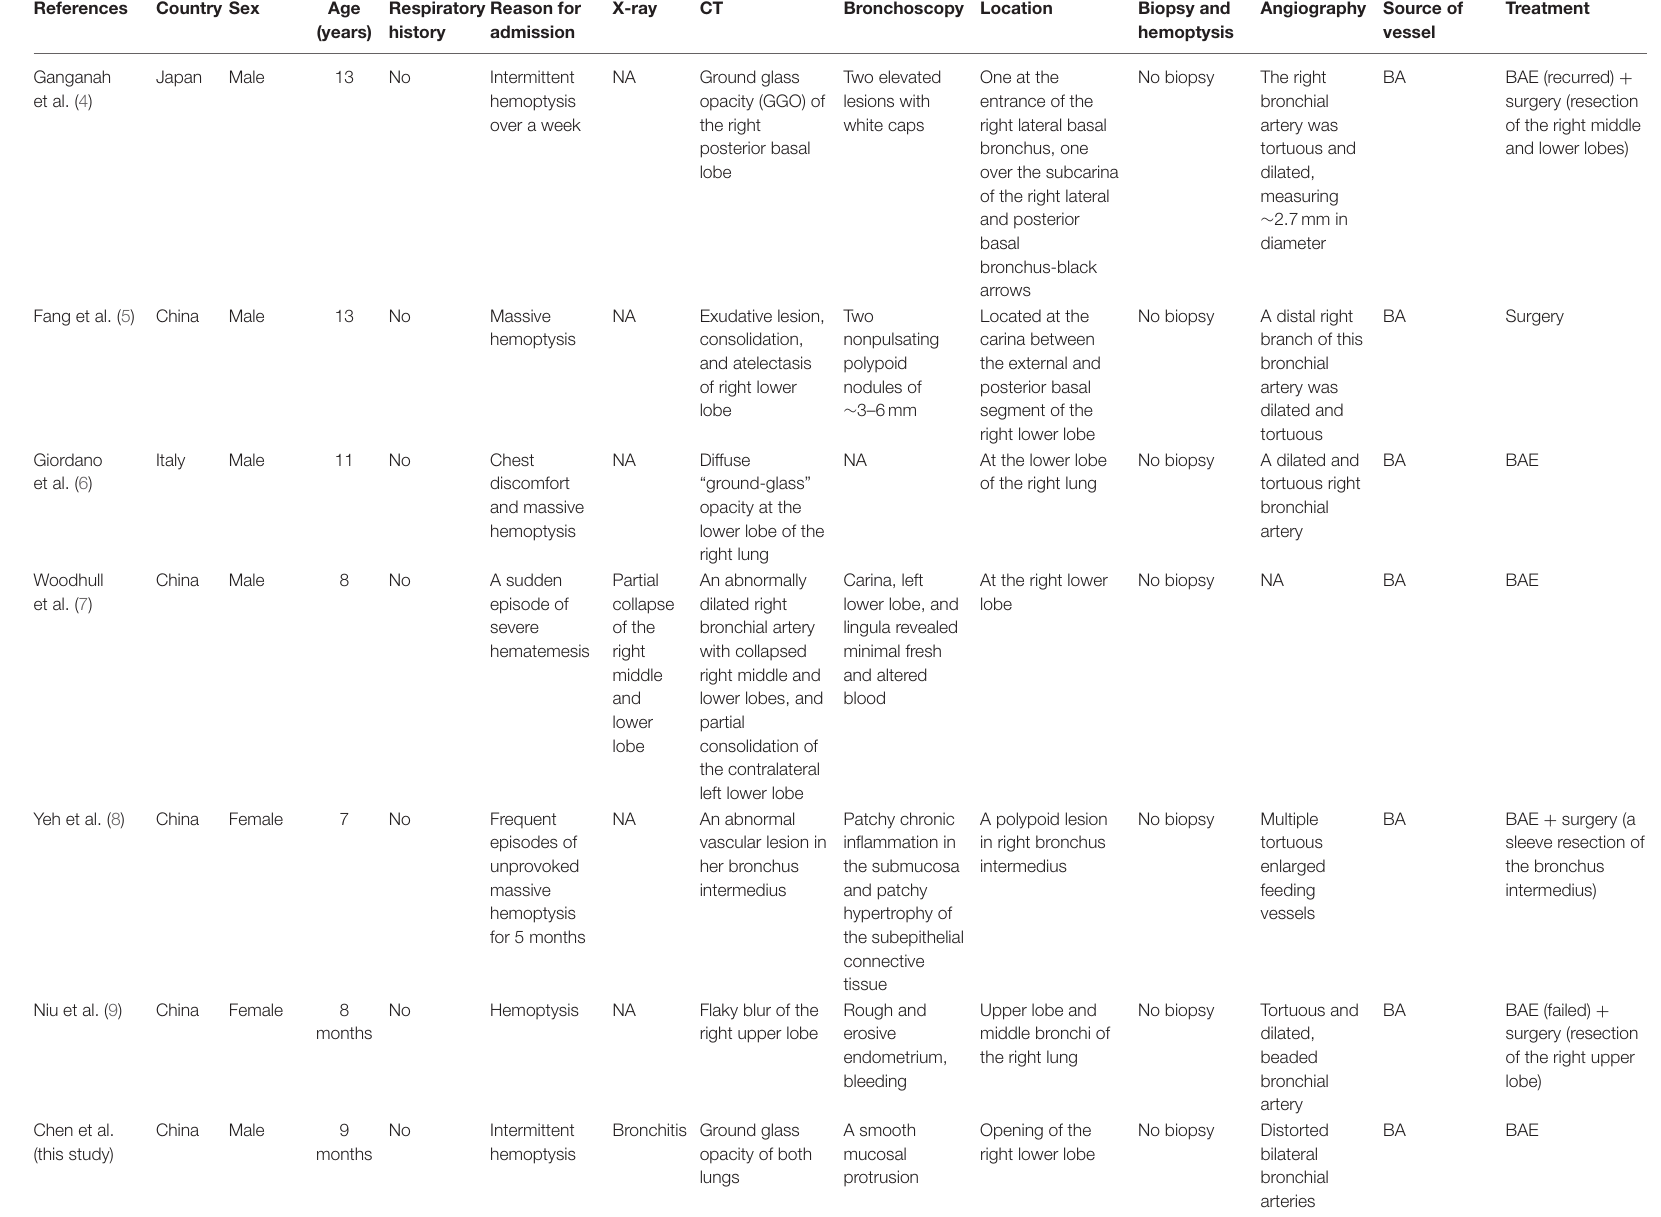
TABLE 1 | Characteristics of pediatric bronchial Dieulafoy’s disease